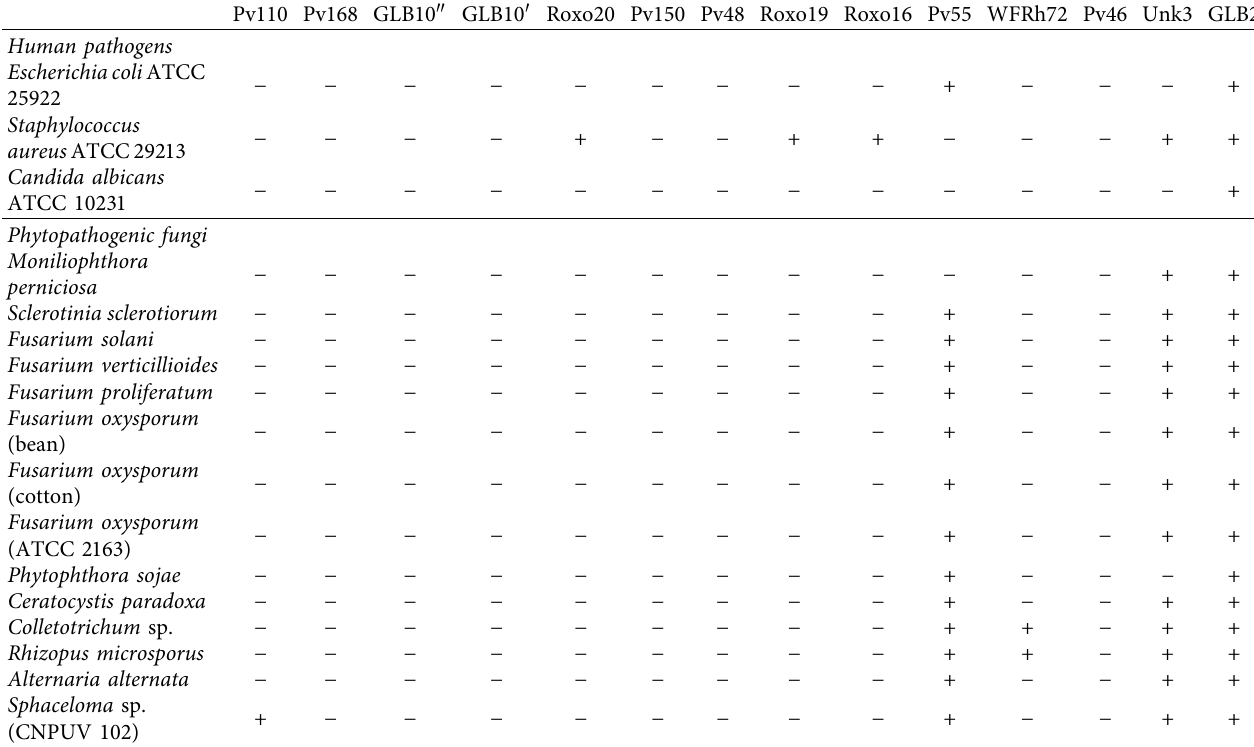
Table 2: Results of the initial screening against pathogens.